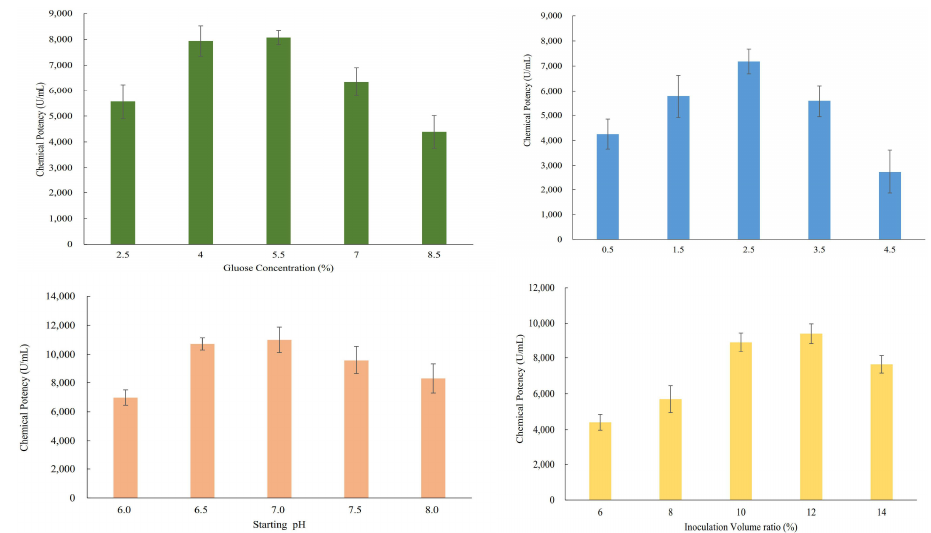
Figure 5. Evaluation results for single factors of glucose concentration, peanut meal concentration, starting pH, and inoculation volume ratio for fermentation.